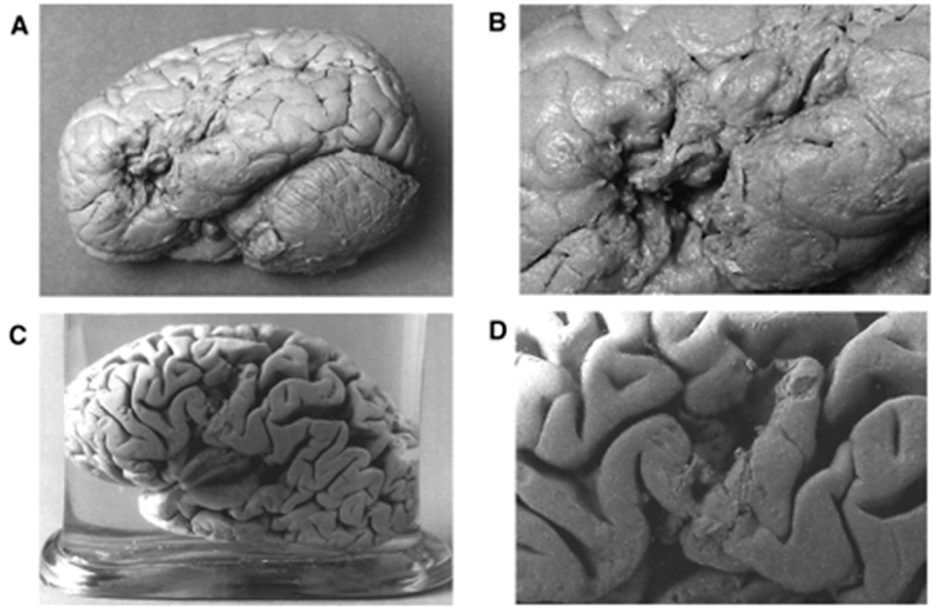
Figure 3. Gross anatomical features of brains of Broca’s patients, L1 (nicknamed Tan) and L2 with aphasia. Panels ( A , C ) are the lateral views of patients L1 ′ s and L2 ′ s brain. Panels ( B , D ) are the close-up of views of the brain lesions for the patients L1 and L2, respectively. Panels ( A ) through ( D ) are adapted with permission from Dronkers et al. (2007).